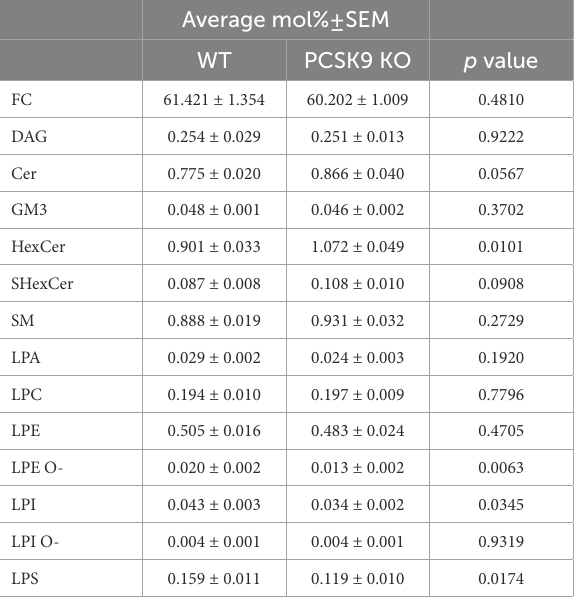
TABLE 2 Lipid classes detected in WT and KO